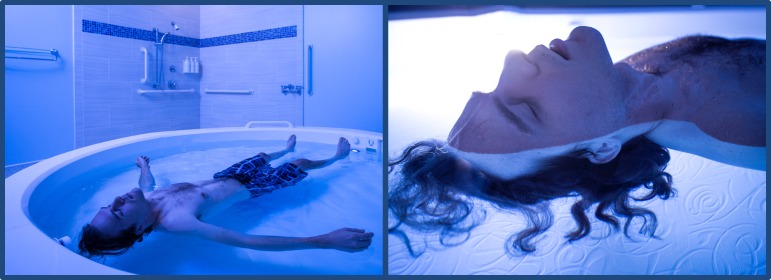
Floatation-REST in an open circular float pool.The circular fiberglass pool is 8 feet in diameter and contains 11 inches of reverse osmosis water saturated with ~1,800 pounds of USP grade Epsom salt (magnesium sulfate), creating a dense salt water solution that is maintained at a specific gravity of ~1.26, allowing participants to effortlessly float on their back while the water hovers just above the ears. A small blue LED light remains illuminated throughout the float session, and can be turned off by the participant through a round air switch (both of which can be seen in the picture, located immediately adjacent to the participant’s right foot). Unlike the picture, clothing is usually not worn while floating since anything touching the body can generate somatosensory stimulation, potentially detracting from the float experience.